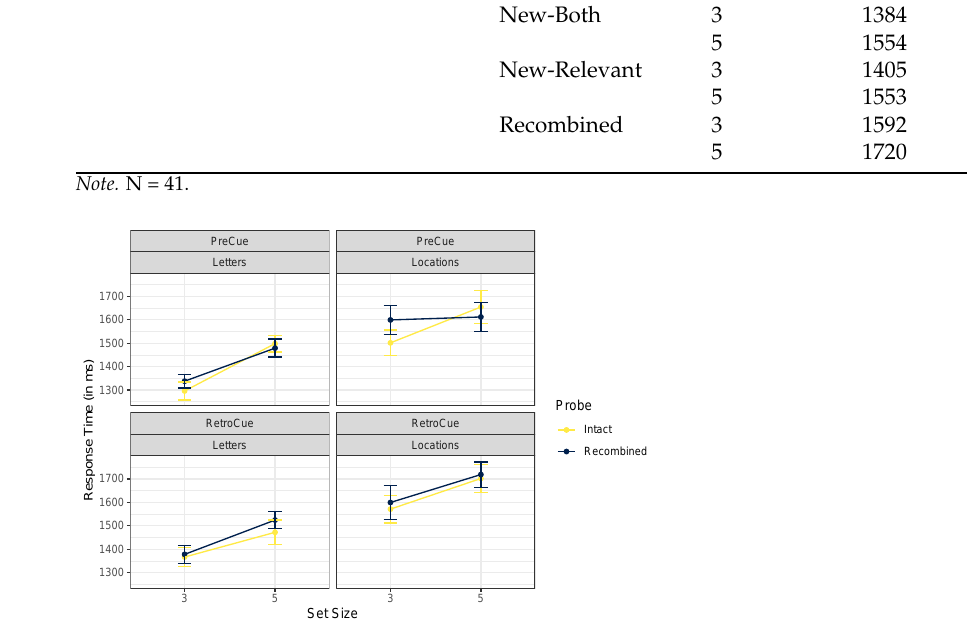
Figure 3. Mean trimmed reaction times, Experiment 1. Error bars mark within-participant standard errors around the mean calculated with the Cousineau–Morey method